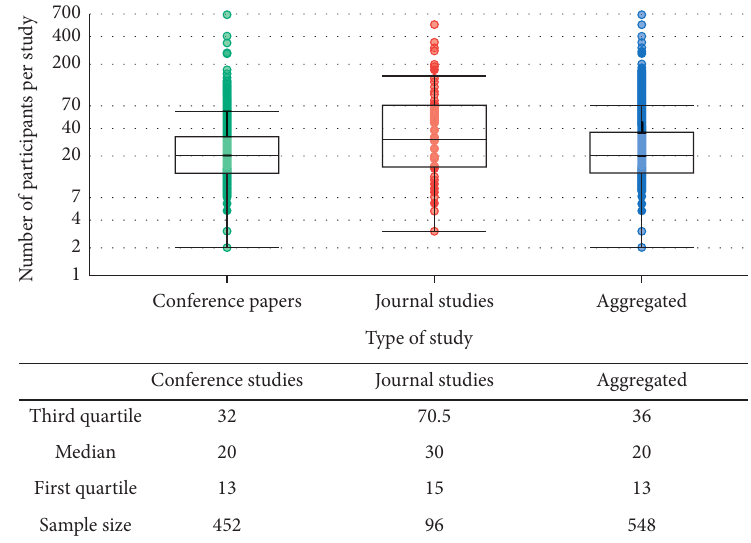
Figure 6: Number of participants per study by the type of the